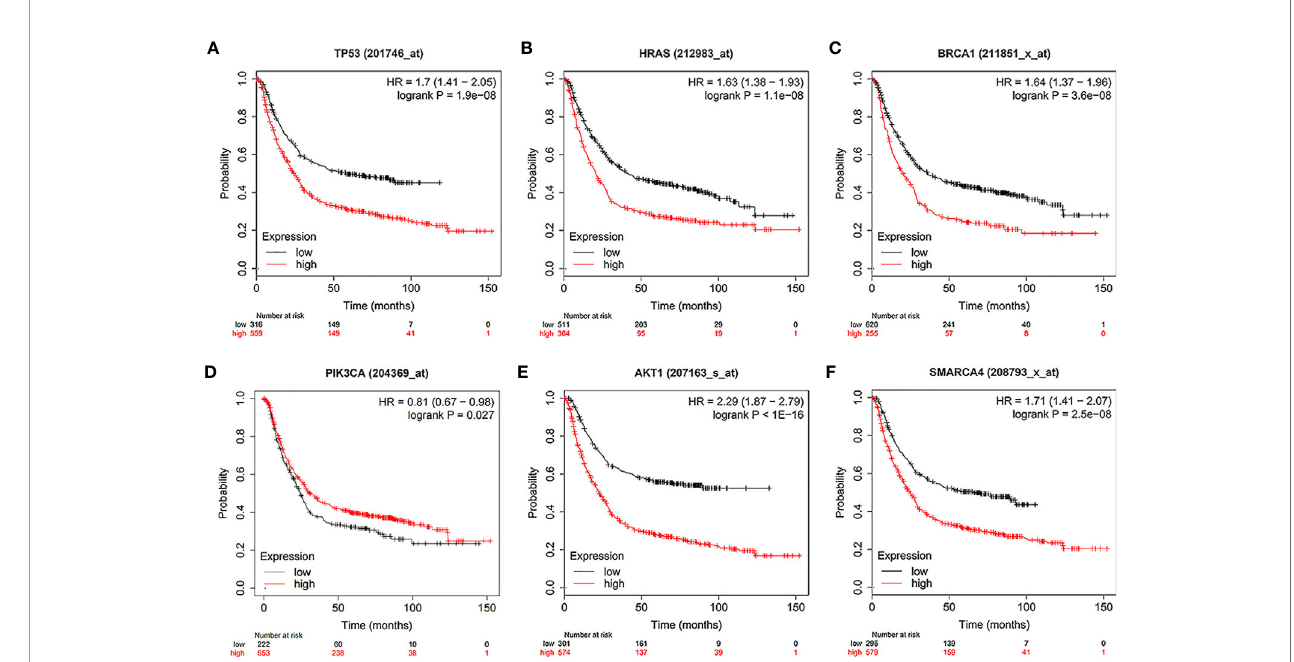
FIGURE 7 | Univariate survival analysis of the key genes using Kaplan-Meier curves. (A) TP300. (B) HRAS. (C) BRCA1. (D) PIK3CA. (E) AKT1. (F) SMARCA4.